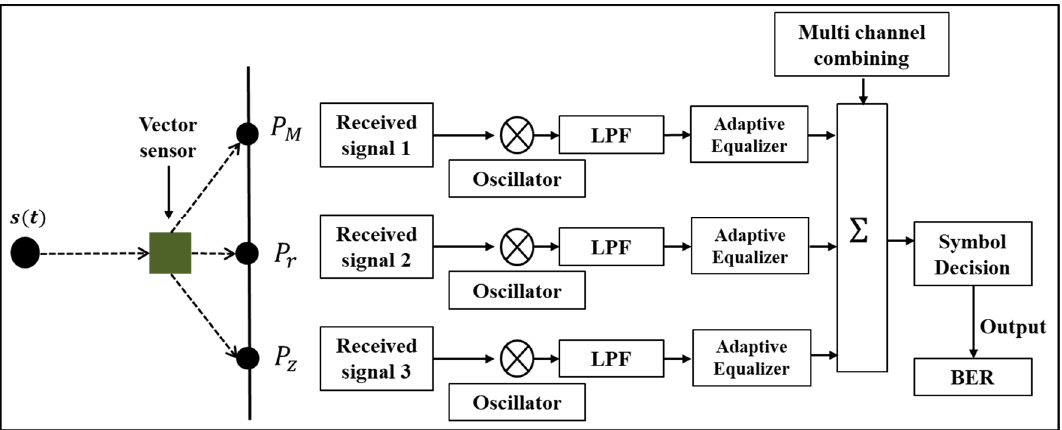
Figure 2. Block diagram of a single-input multiple-output (SIMO) system using a single-vector sensor. P M is an acoustic pressure. P r and P z are the horizontal and vertical components of the pressure equivalent particle velocities, respectively.